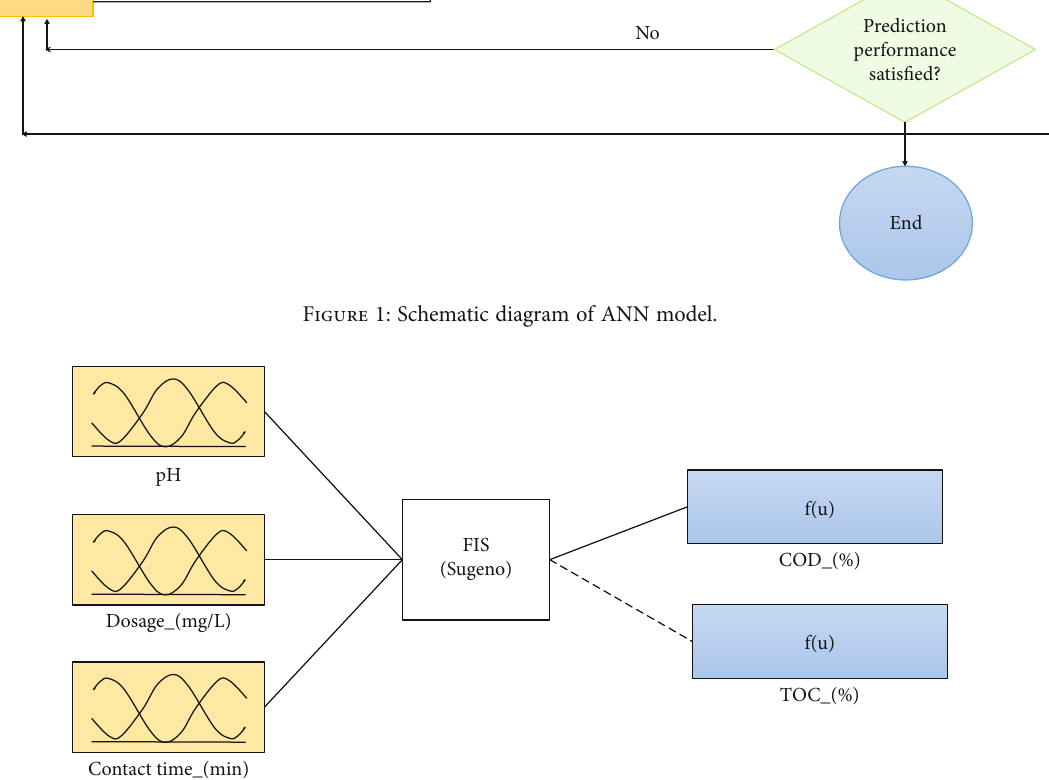
Figure 2: Schematic diagram of